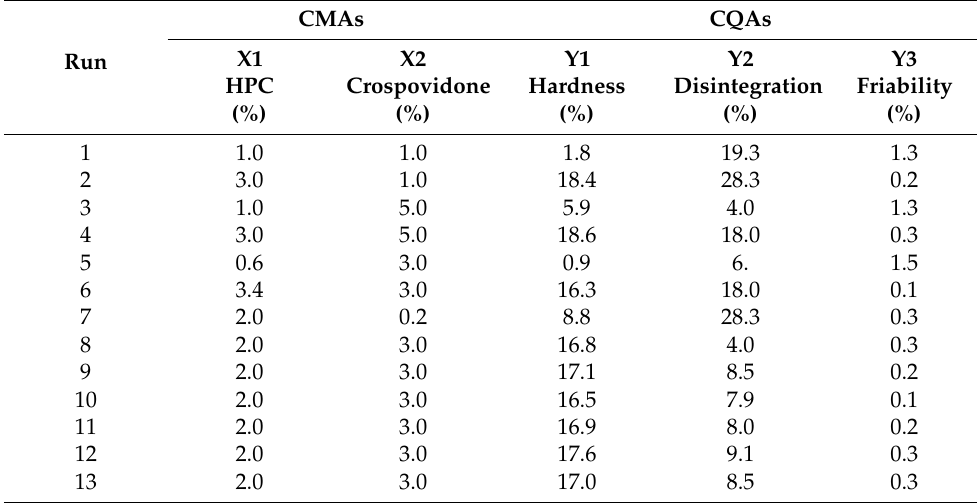
Table 6. Critical material attributes (CMAs) affecting critical quality attributes